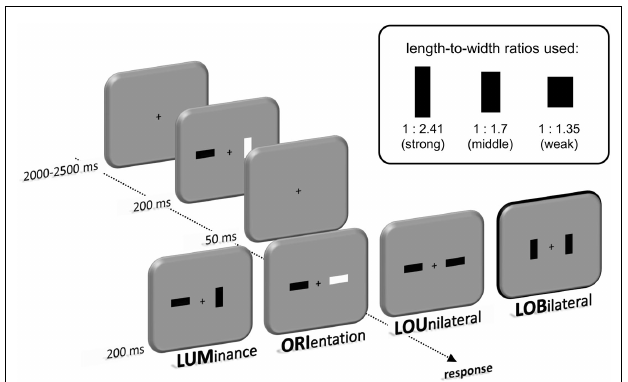
FIGURE 1 | Set-up and procedure. With a break of 50ms two 200ms lasting frames were presented that contained two rectangular bars lateral to a central fixation cross. Across these frames the luminance (LUM) or orientation (ORI) of these bars could change.These changes could also occur together at the same location (LOU) or spatially separated (LOB). Three different length-to-width ratios of the bars were used in order to modulate the salience of the motion transient. Participants had to respond by pressing a key at the side of the luminance